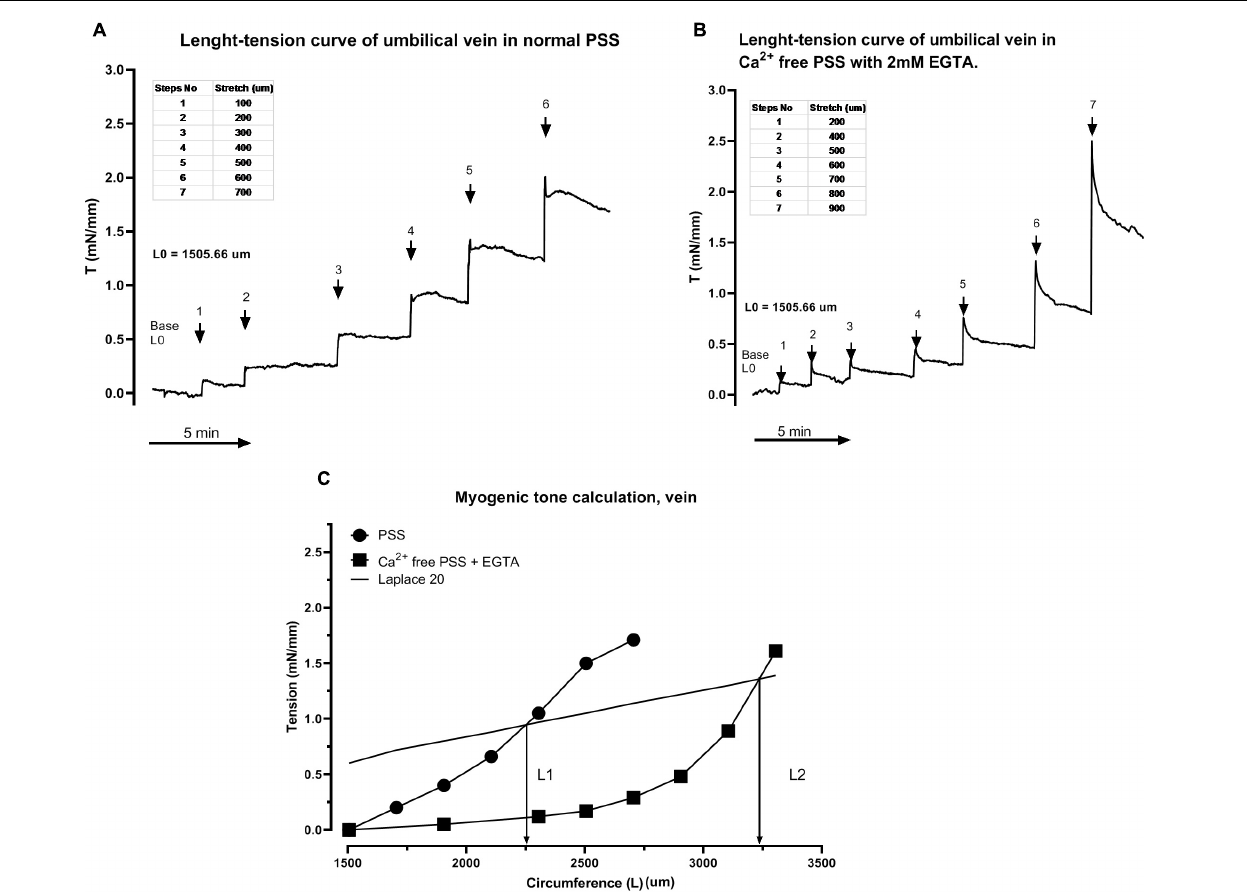
FIGURE 4 | Representative tracing of the experimental protocol in an umbilical vein for myogenic tone measurement. Length-tension (L-T) curve in PSS (A) . Length-tension curve in Ca 2 + free PSS (B) . Determination of myogenic tone (C)